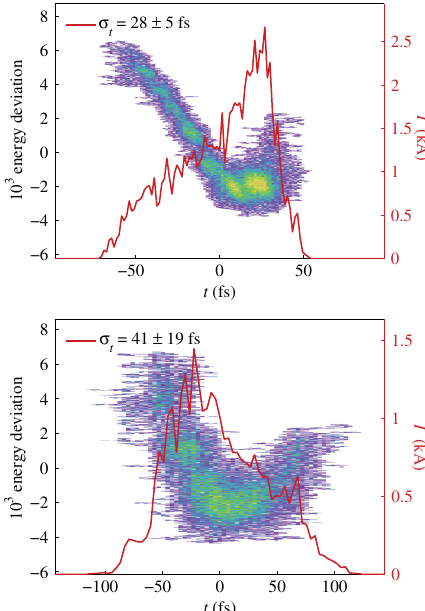
FIG. 4. Calculation of the longitudinal rms bunch length σ t;b including statistical errors and corrections due to the intrinsic longitudinal-to-vertical correlation C and the intrinsic vertical y rms beam size σ . The plots show the measured vertical rms y 0 beam sizes σ 2 averaged over 20 single shots for three shear y ¼ 0 . The upper plot data have been parameters, at (cid:3) S and S y y taken during the 13.5 nm run, the lower plot during the 24 nm run. The black curve represents a 2nd degree polynomial